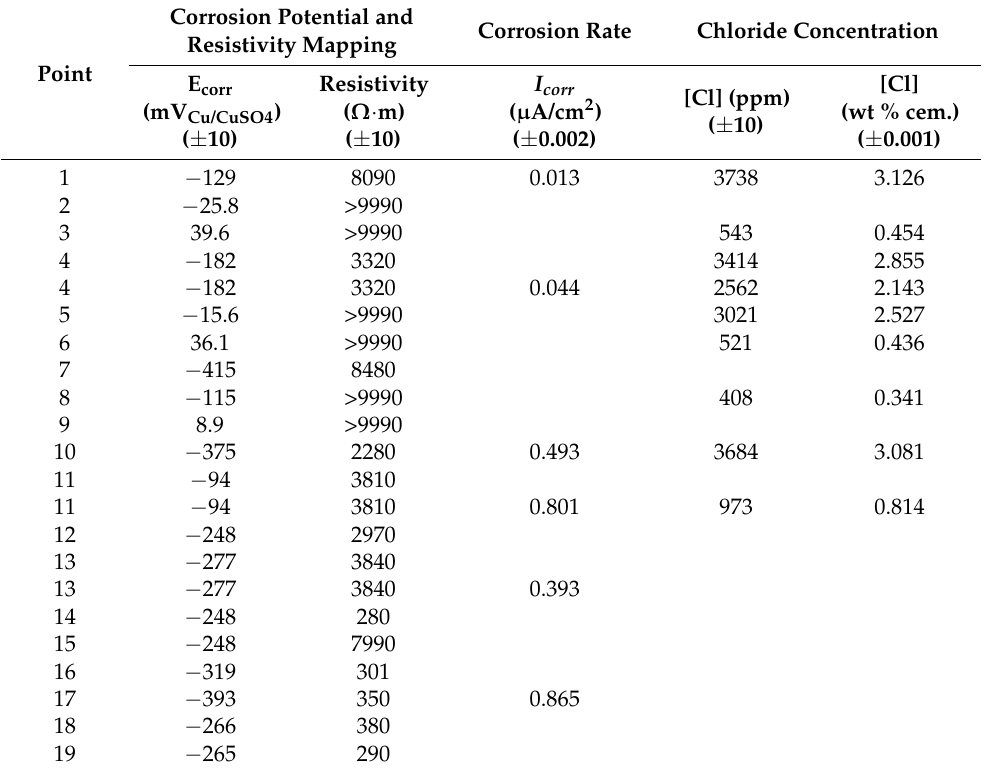
Table 3. Corrosion parameters, hXRF chloride quantification, and per cent of chloride ions by cement weight.